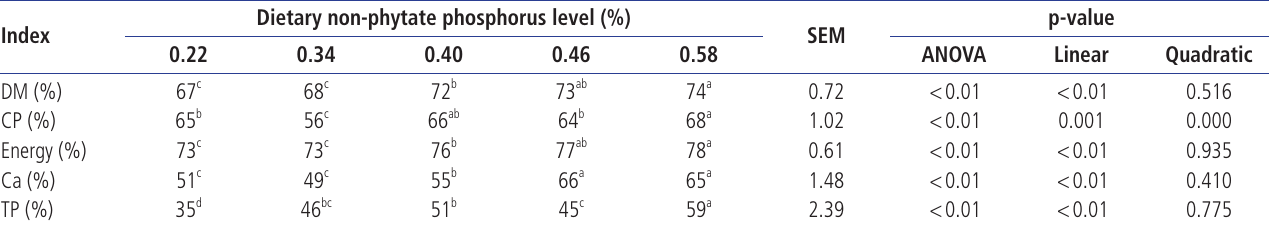
Table 7. Effect of dietary non-phytate phosphorous levels on excreta nutrient utilization of